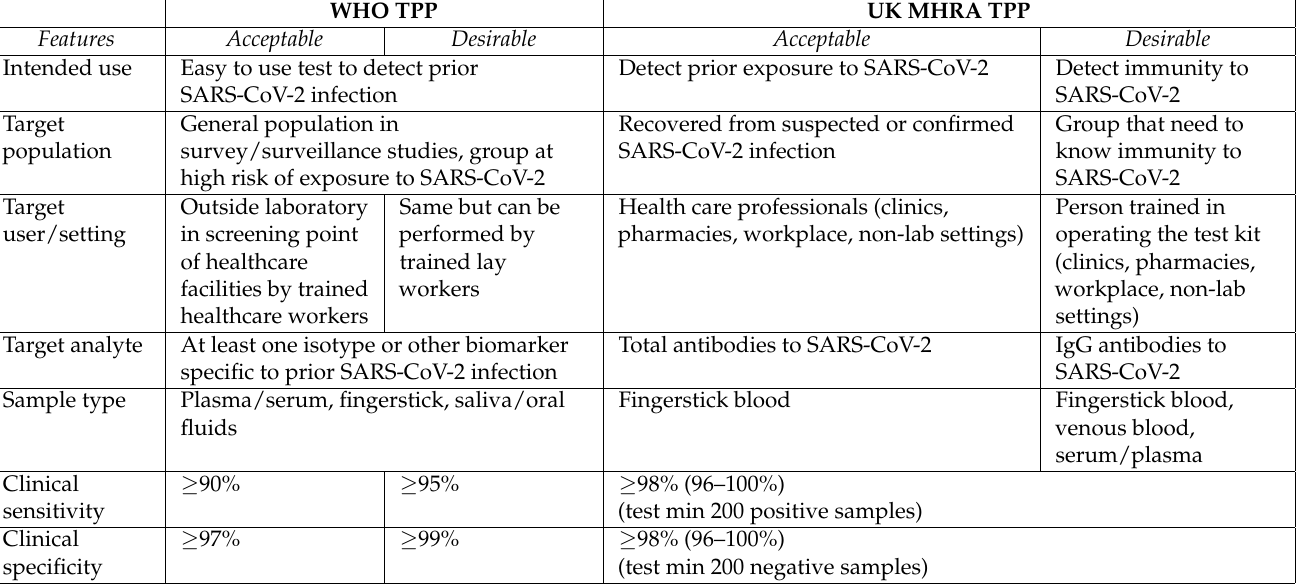
Table 2. TPP, point-of-care rapid tests for prior SARS-CoV-2 infection (antibody